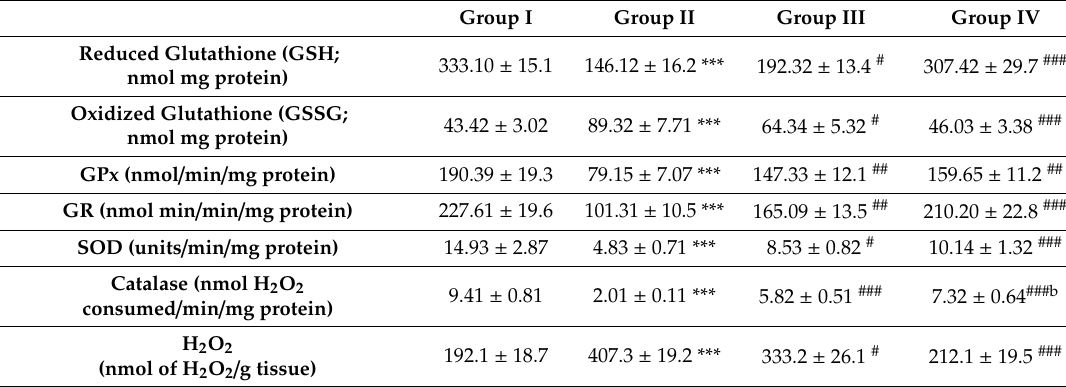
Table 2. Effect of treatment of naringenin on glutathione dependent and other antioxidant enzymes in different experimental groups.